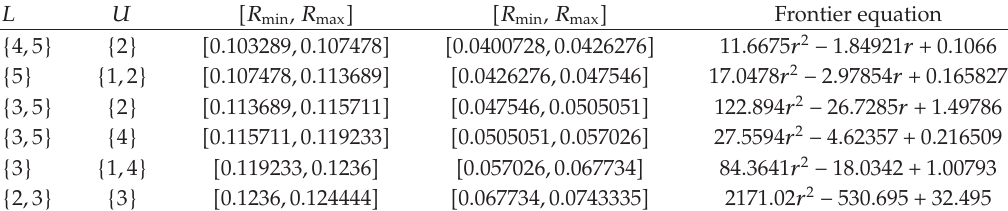
Table 7: Non-degenerate cases.